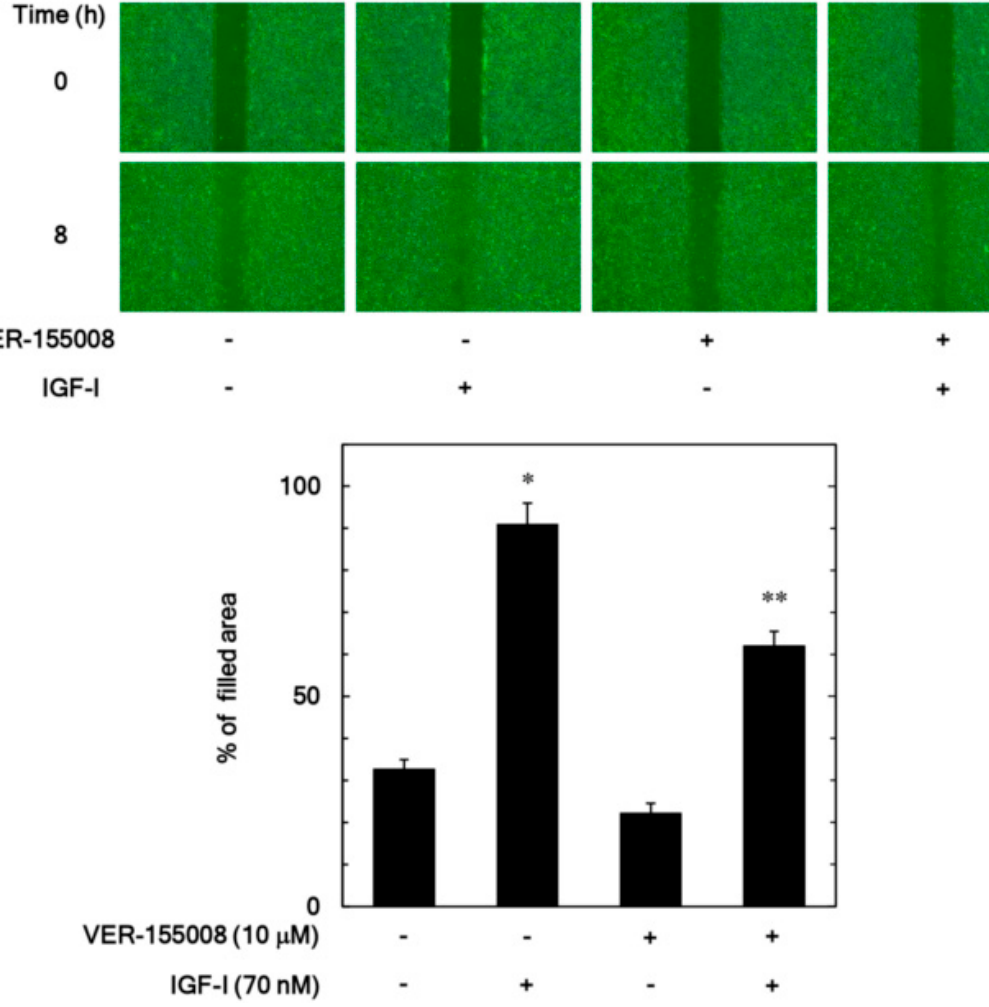
Figure 1. Effect of VER-155008 on the insulin-like growth factor-I (IGF-I)-induced migration of MC3T3-E1 cells. The migration was evaluated by a wound-healing assay. The cells were pretreated with 10 µ M of VER-155008 or vehicle for 60 min and then stimulated by 70 nM of IGF-I or vehicle for 8 h. The cells were photographed before IGF-I-stimulation (0 h) and, after 8 h (upper panel, a representative result), the area of migrated cells was measured (lower bar graph), which were obtained from triplicate independent experiments. * p < 0.05 compared to the value of the control cells without IGF-I stimulation. ** p < 0.05 compared to the value of IGF-I alone.